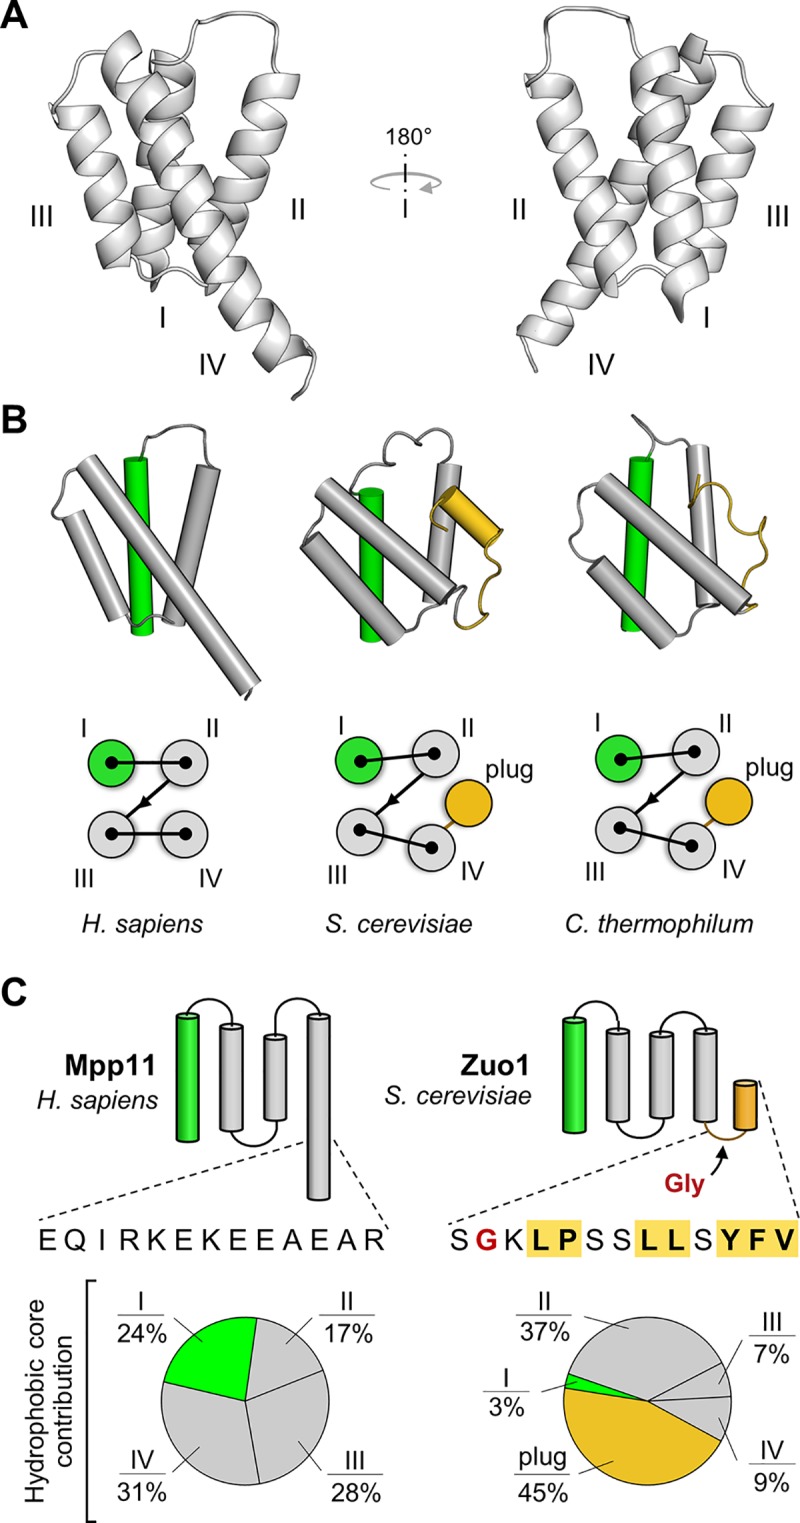
Structure of the 4HB domain.(A) Structure of the 4HB domain of human Zuotin (Mpp11346-432) determined by NMR (PDB ID: 6CGH). Four helices (I-IV) form a compact structure with the longest helix, Helix IV, protruding out of the bundle. (B) Comparison of 4HBs of human and fungal Zuotin. (top) 4HBs are presented in the same orientation, with helices represented as cylinders. The C-terminal plug segment following Helix IV in fungal Zuotins are highlighted in gold; Helix I is in green. S. cerevisiae (PDB ID: 2LWX) and Chaetomium thermophilum (PDB ID: 4GMQ). (bottom) Schematic of organization of 4HBs—Helices I-IV and fungal plugs. (C) Contribution to the hydrophobic core. (top) Graphic of organization of Mpp11 and Zuo1 4HB, highlighting the C-termini. The C-terminal 13 residues of the bundles are shown. Residues of the S. cerevisiae plug shown to be required for Pdr1 activation are highlighted in yellow, with bold lettering. Glycine that allows the plug to fold back into the bundle in red. (bottom) Pie chart presenting individual contribution to the 4HB hydrophobic core by Helices I, II, III and IV, and for Zuo1 the hydrophobic plug, estimated based on their calculated individual hydrophobic surfaces using the NMR-derived ensembles–PDB ID: 6CGH (human Mpp11) and PDB ID: 2LWX (S. cerevisiae Zuo1).